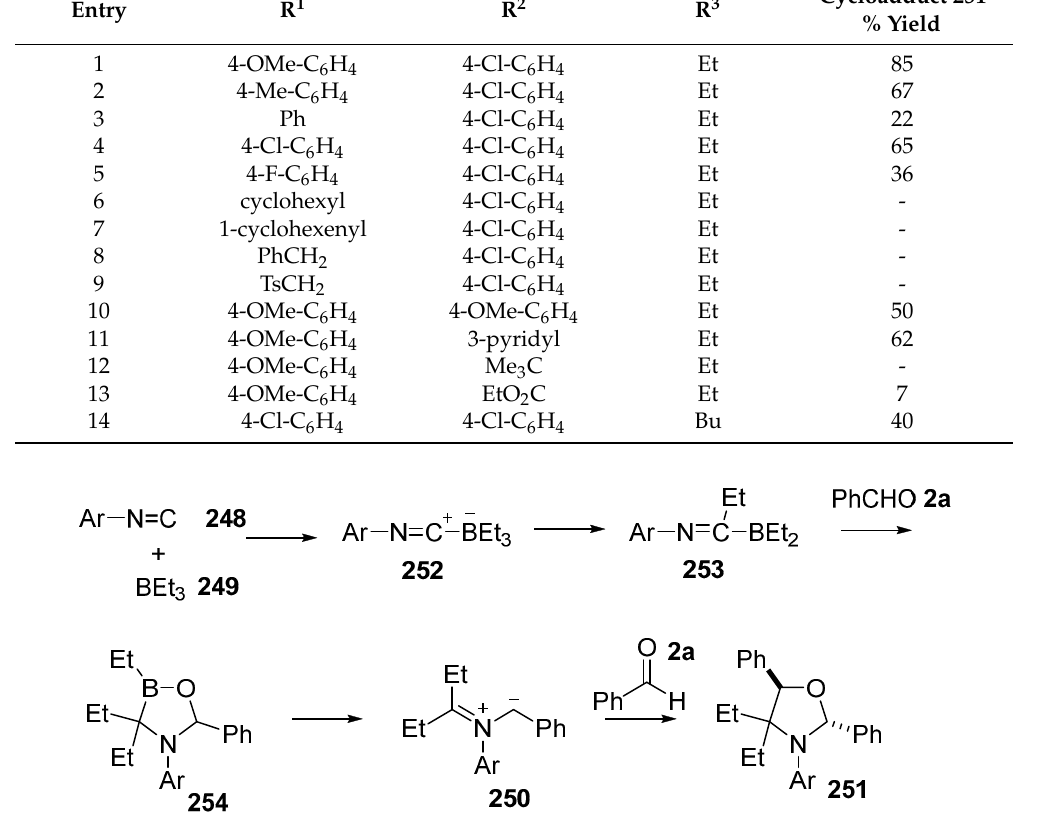
Table 35. Multicomponent reaction of aldehydes 2 , isocyanides 248 and trialkylboron reagents 249 (Scheme 73).